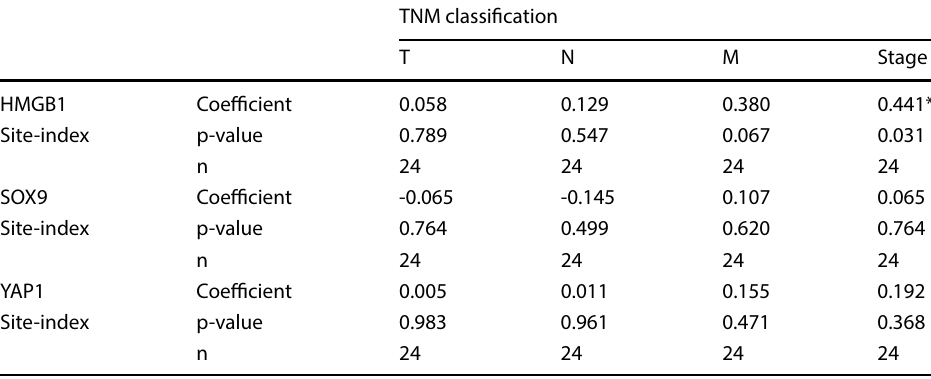
Table 3 The correlation between the site-index of the potential markers and TNM